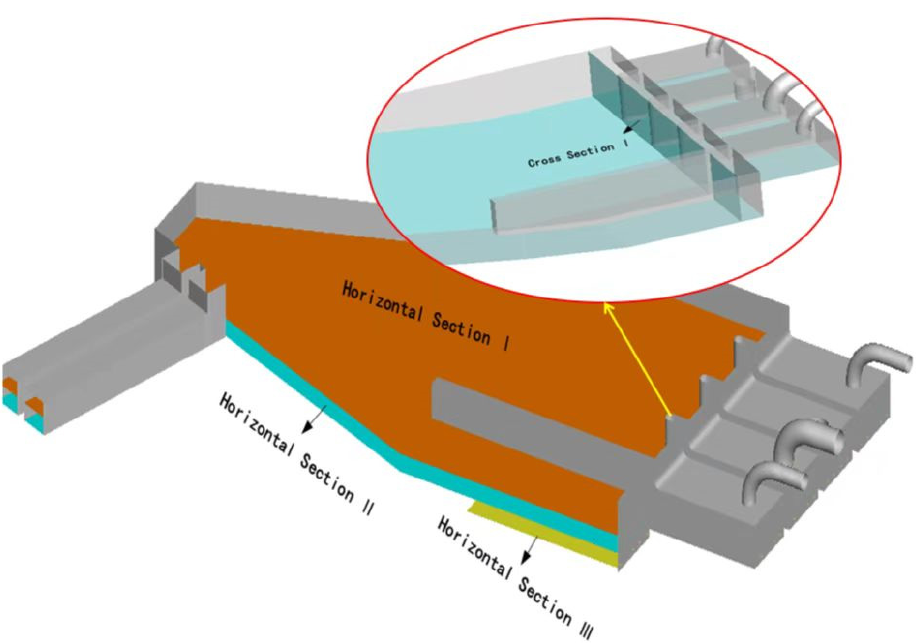
Figure 4. Typical Figure 4. Typical sections.